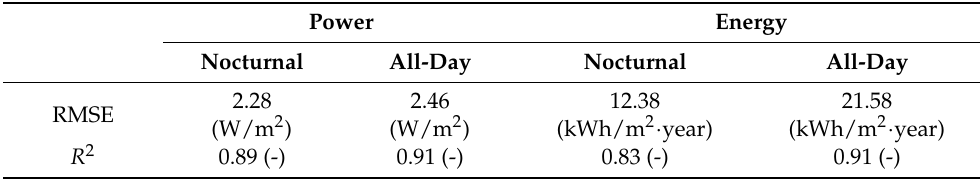
Table 3. Performance of the nocturnal and all-day